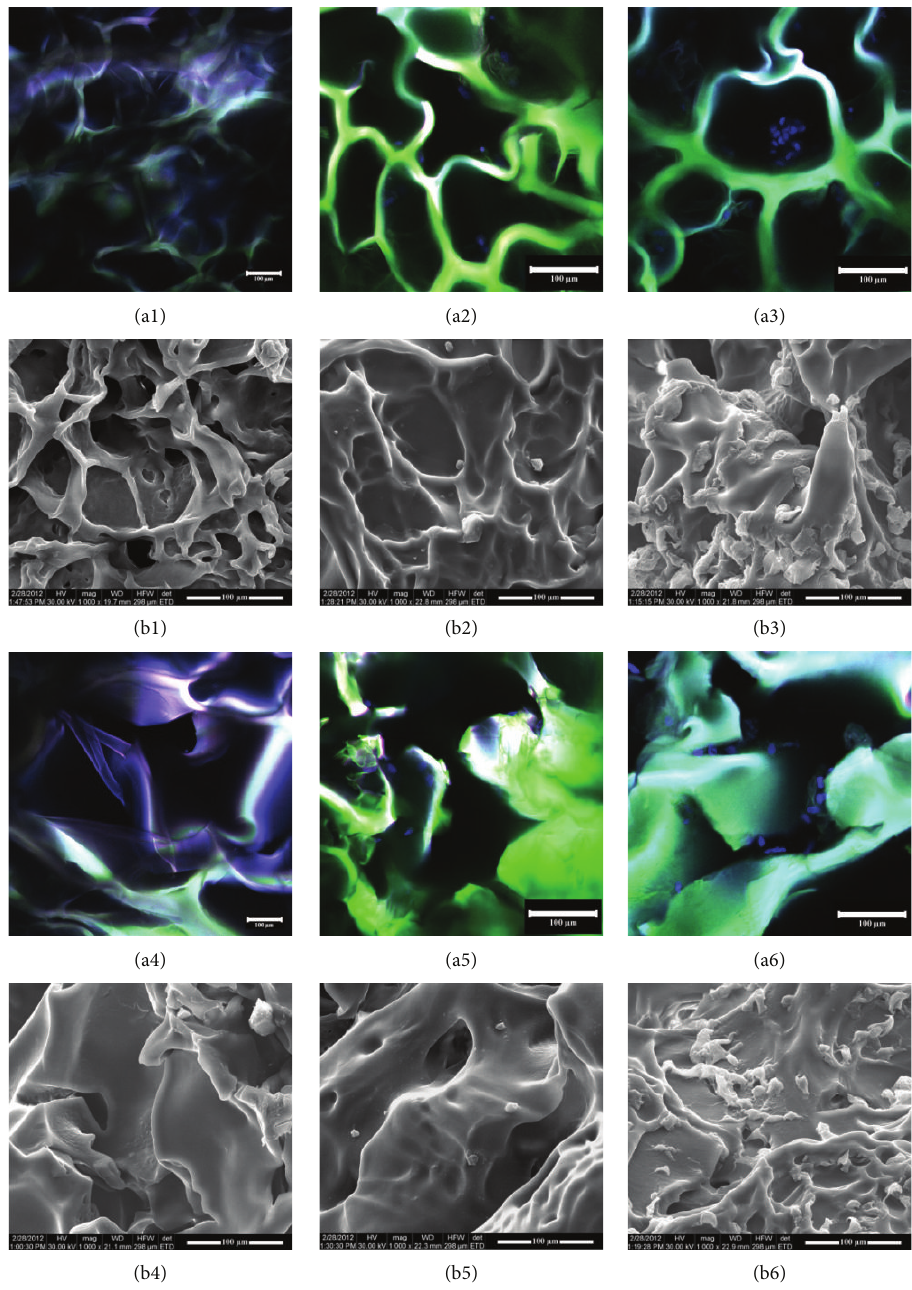
Figure 2: Confocal fluorescence microscopy (a) and SEM micrographs (b) showing G-A-PAA scaffold morphology: 1, unseeded; 2, at 24 h after seeding; 3, at 7 days after seeding; G-A scaffold morphology: 4, unseeded; 5, at 24 h after seeding; 6, at 7 days after seeding. Confocal microscopy images show the autofluorescence of the matrix (green) and DAPI-stained nuclei